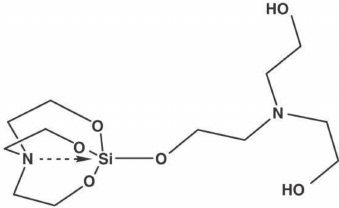
Figure 3. Structure of silatrane. Reprinted with permission from Reference [38]. Copyright (2007) The American Ceramic